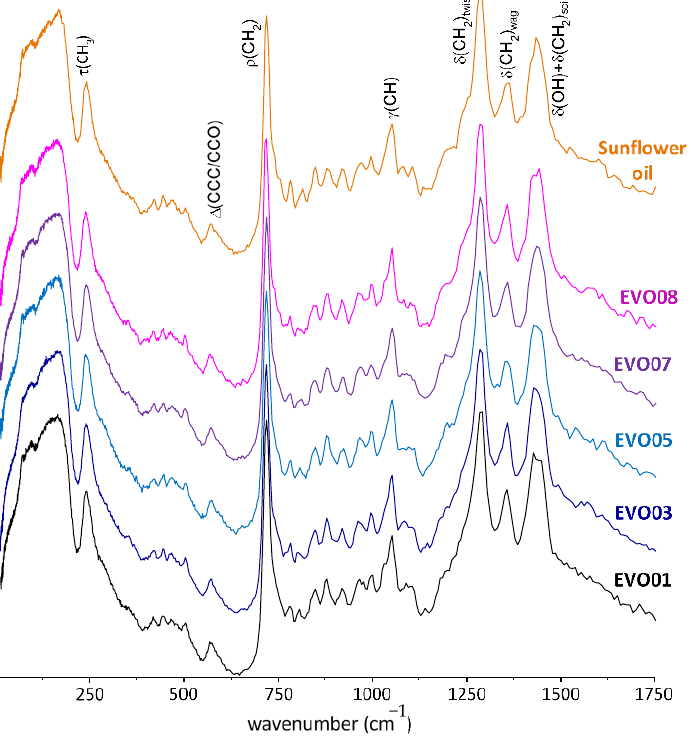
Figure 1. INS spectra (0–1750 cm − 1 ) of some of the extra virgin olive oils (EVOOs) studied in the present work, and of sunflower oil.